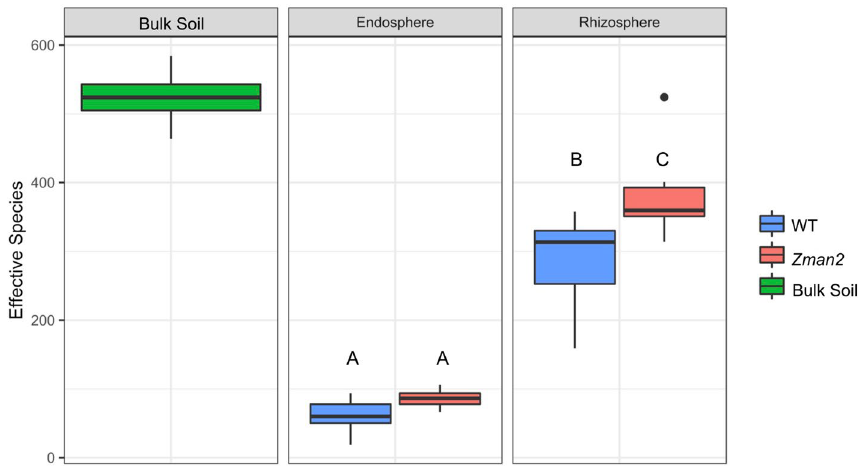
Figure 3. Alpha diversity of each sample type, as measured by the Shannon’s H index. Letters represent significantly different measurements, p ≤ 0.05. All statistics are available in Supplemental Table 2. n = 5 (bulk soil) or n = 6 (all plant